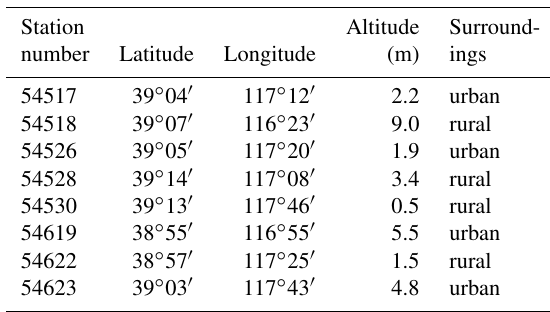
Table 3. Metadata information of the nine stations used to build reference